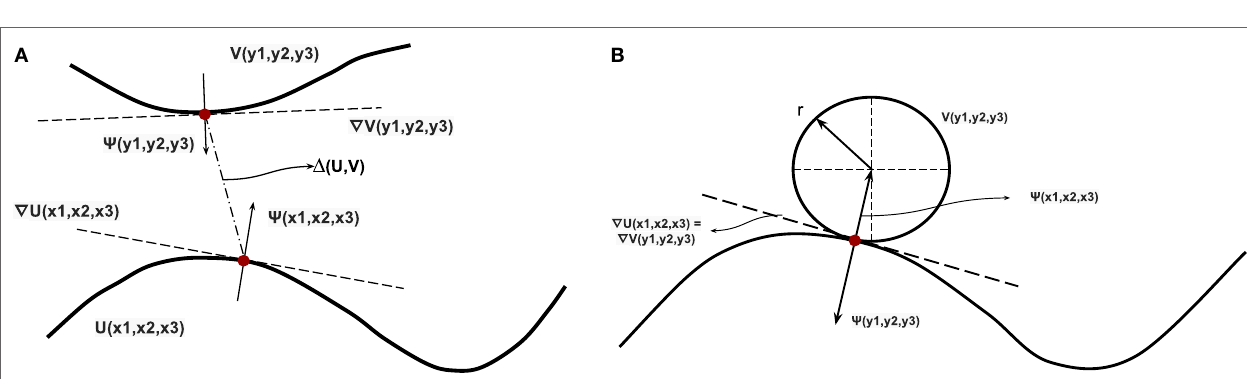
FIGURE 6 | (A) Two parametric surfaces represented by U ( x 1 , x 2 , x 3 ) and V ( y 1 , y 2 , y 3 ) and their surface gradients shown as r U ( x 1 , x 2 , x 3 ) and r V ( y 1 , y 2 , y 3 ), respectively, (B) Point contact between a parametric surface U ( x 1 , x 2 , x 3 ) and a sphere V ( y 1 , y 2 , y 3 ). At point contact, their surface gradients r U ( x 1 , x 2 , x 3 ) and r V ( y 1 , y 2 , y 3 ) are equal to each